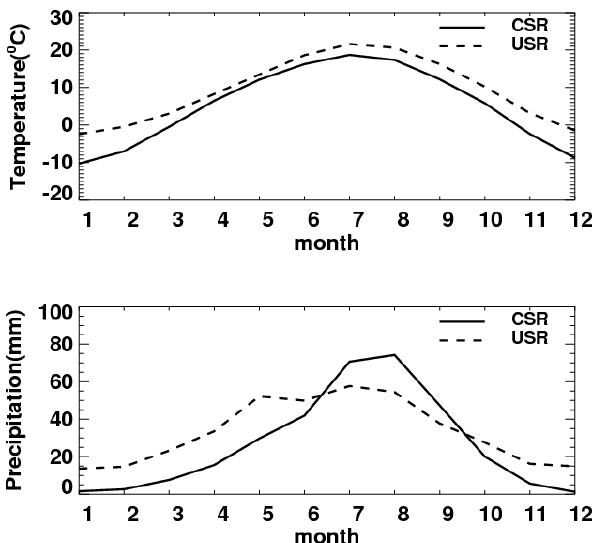
Fig. 2. Comparison of annual temperature ( ℃ ) and precipitation (mm) cycles over the CSR and USR.